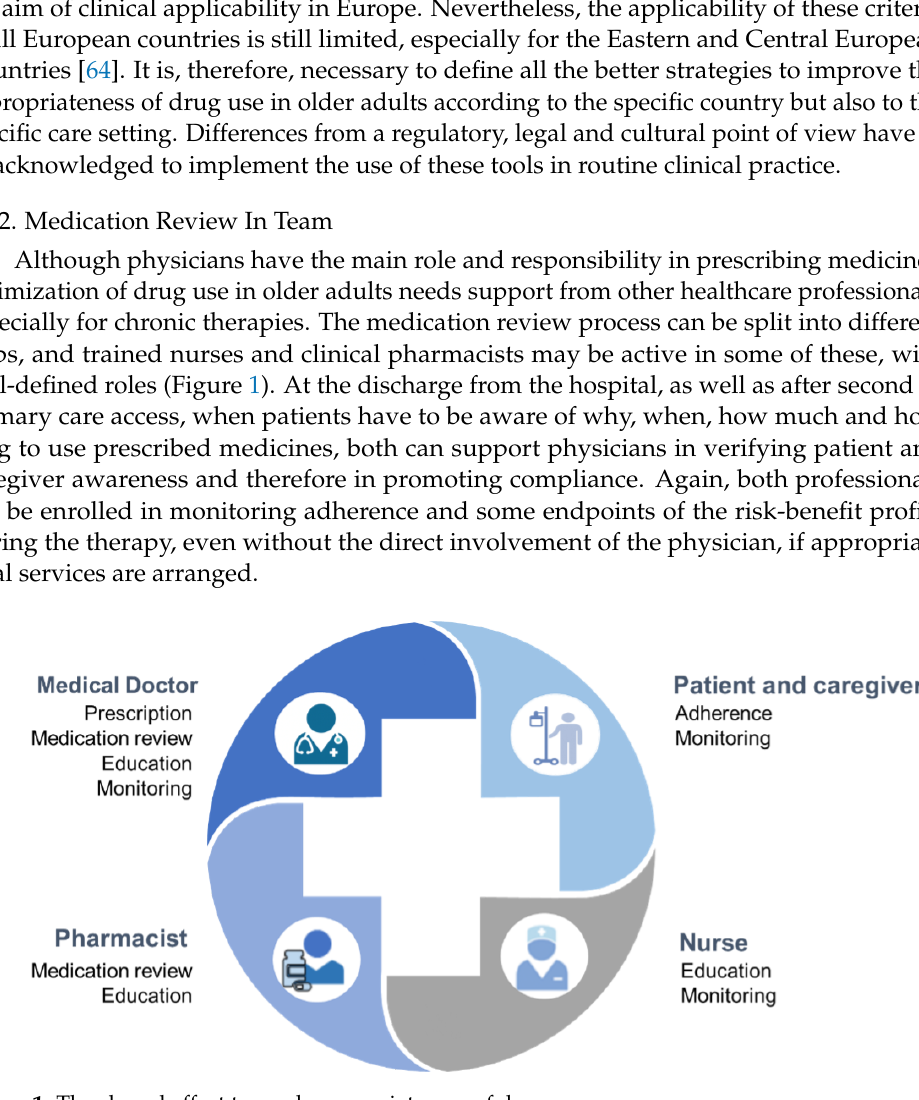
Figure 1. The shared effort toward appropriateness of drug